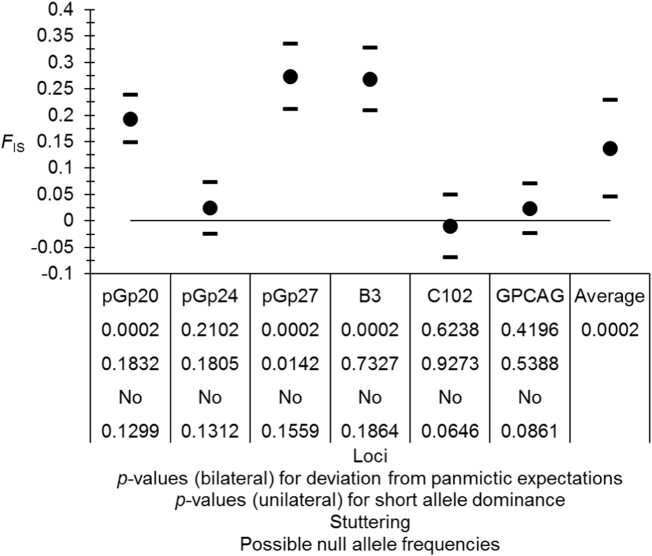
FIS observed in subsamples of Glossina palpalis palpalis from Ivory Coast for autosomal loci only with jackknife's over subsamples 95% confidence intervals for each locus and 95% Bootstrap over loci confidence interval for the average. Results of panmictic tests, short allele dominance tests, stuttering detection and possible null allele frequencies are also given.